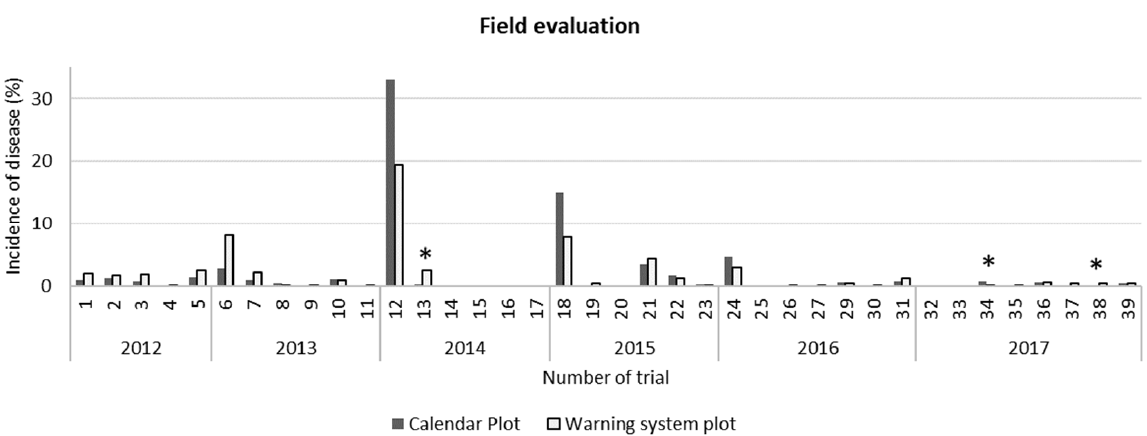
Figure 3. Incidence of disease recorded in the field in each trial conducted along 6 seasons in calendar plot ( ) and warning system plot ( ). Mean values with (*) mean statistical differences between the incidence of disease recorded in the calendar plot in comparison with the warning system plot according to Student’s LSD ( p ‐ value < 0.05).